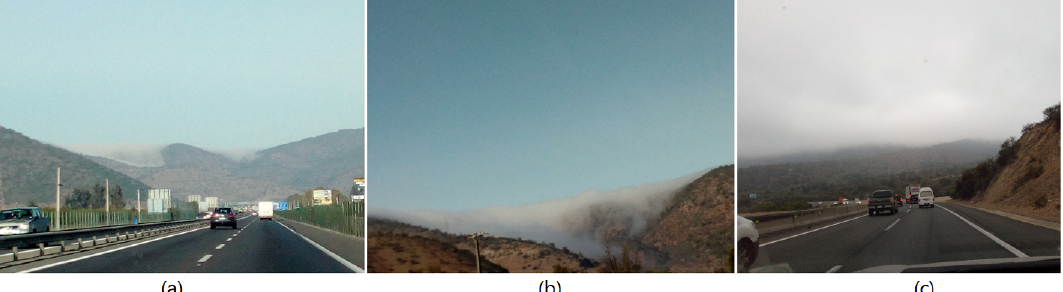
Figure 1. Example of a cloud intersecting with the Chilean coastal range in Lo Prado tunnel, west from Santiago, Chile’s capital. ( a ) shows the east side of the tunnel. It is possible to see a clear sky at that side of the range; ( b ) shows a close up to the top of the mountain over the tunnel, where the cloud is appearing; ( c ) presents the situation at the west side of the tunnel, where there is a cloudy sky. Images were taken on 11 November 2019, in trip from Santiago to Valparaiso, before and after crossing the